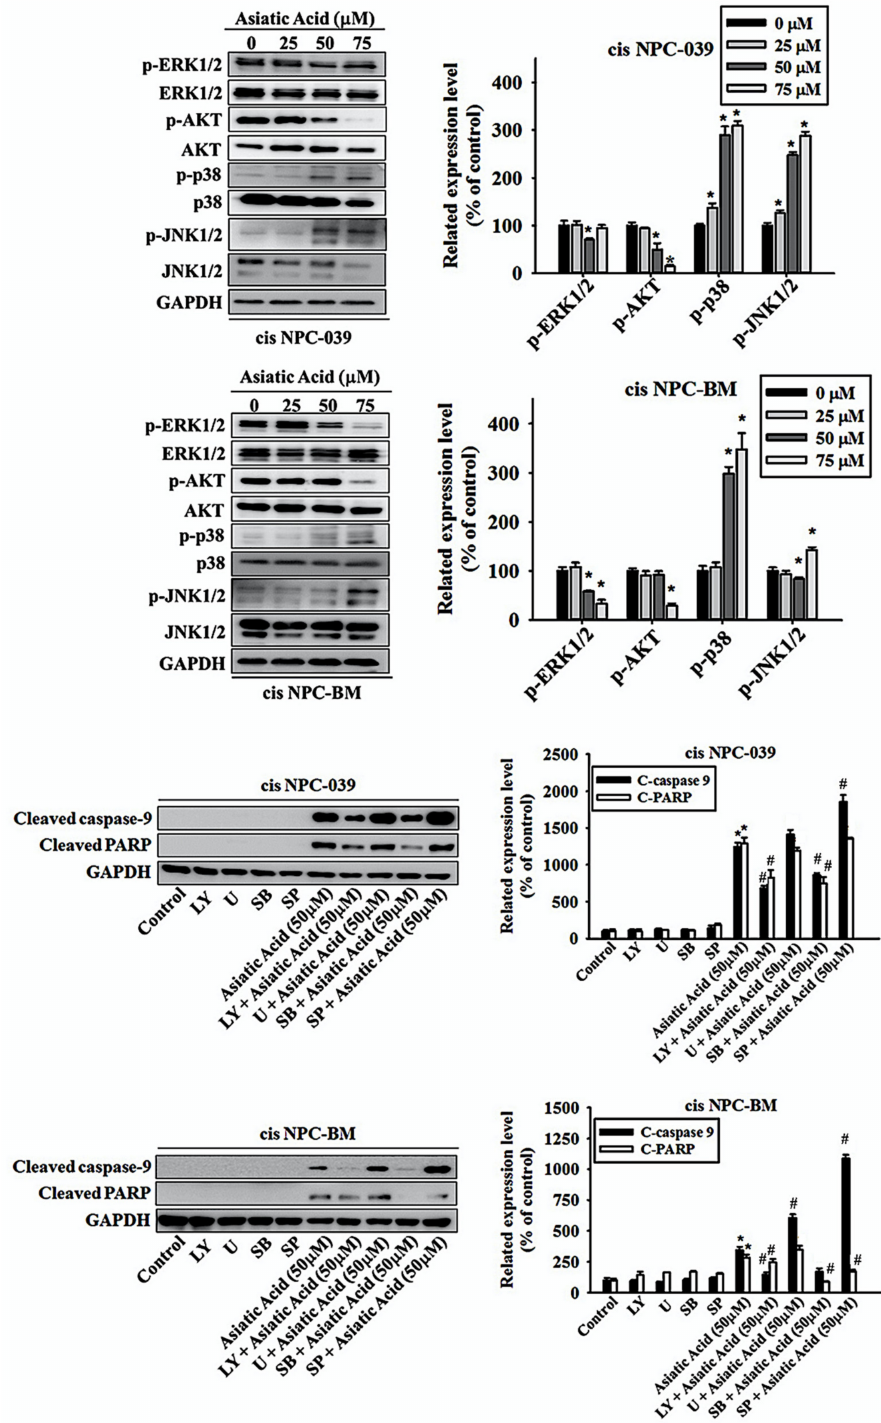
Figure 6. E ff ect of Asiatic acid on the MAPKs and AKT pathway in cis NPC-039 and cis NPC-BM cell lines ( a ) The expression levels of ERK1 / 2, AKT, p38, and JNK1 / 2 were detected by Western blot. ( b ) The protein levels were quantified and normalized to GAPDH using a densitometer. * p < 0.05 versus control group. ( c ) After pretreated with ERK1 / 2, AKT, p38, and JNK1 / 2 inhibitors separately (U, LY, SB, SP), the expression levels of cleaved caspase-9 and PARP were detected by Western blot. ( d ) The protein levels were quantified and normalized to GAPDH using a densitometer. * p < 0.05 versus control group. # p < 0.05, compared with Asiatic acid treated